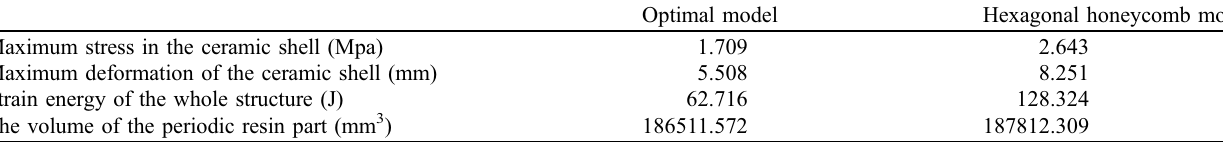
Table 2. Comparison of the optimal model and the hexagonal honeycomb model.